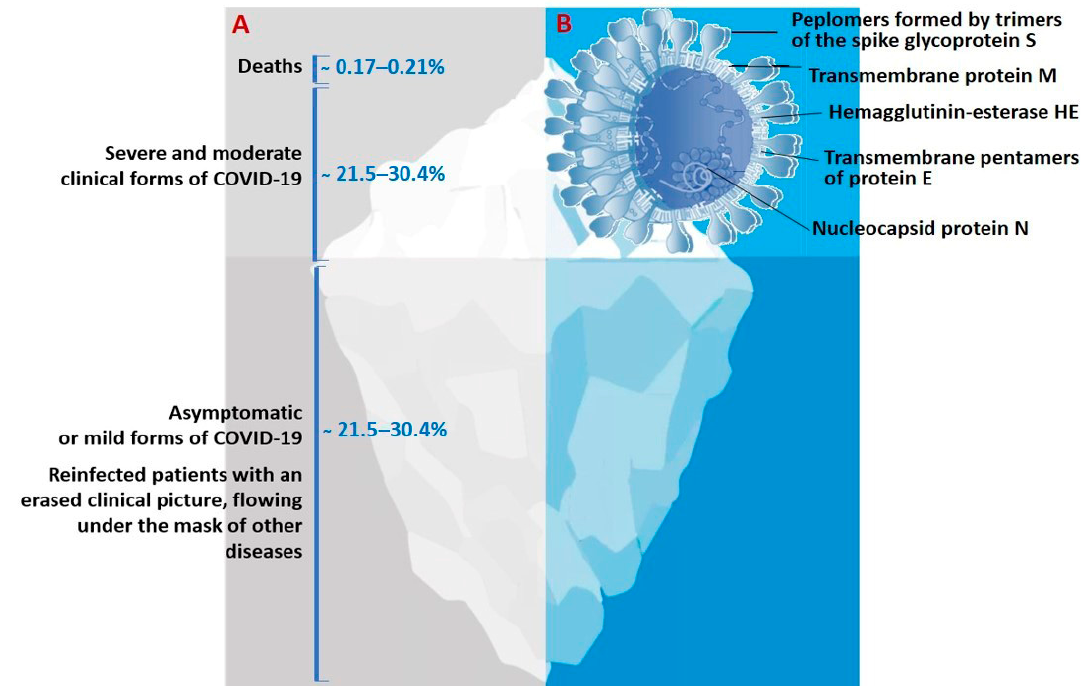
Figure 1. ( A )The actual picture of the spread of COVID-19, resembling an iceberg and ( B ) some of the SARS-CoV-2 structural proteins of biotechnological and pharmacological